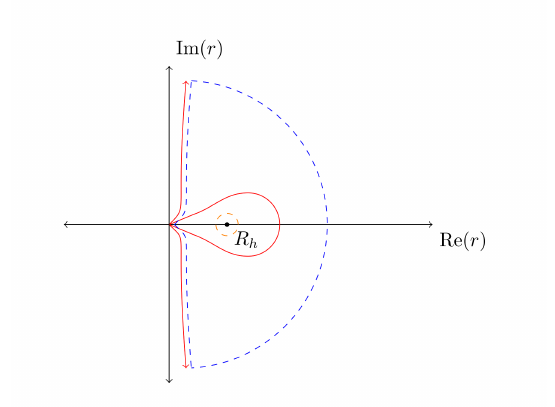
Figure 4 . Schematic depiction of the small and big contours as the orange and blue dashed lines respectively. The orange contour is to be interpreted as arbitrarily close to R are depicted by red curves. Naturally, not all Stokes lines are